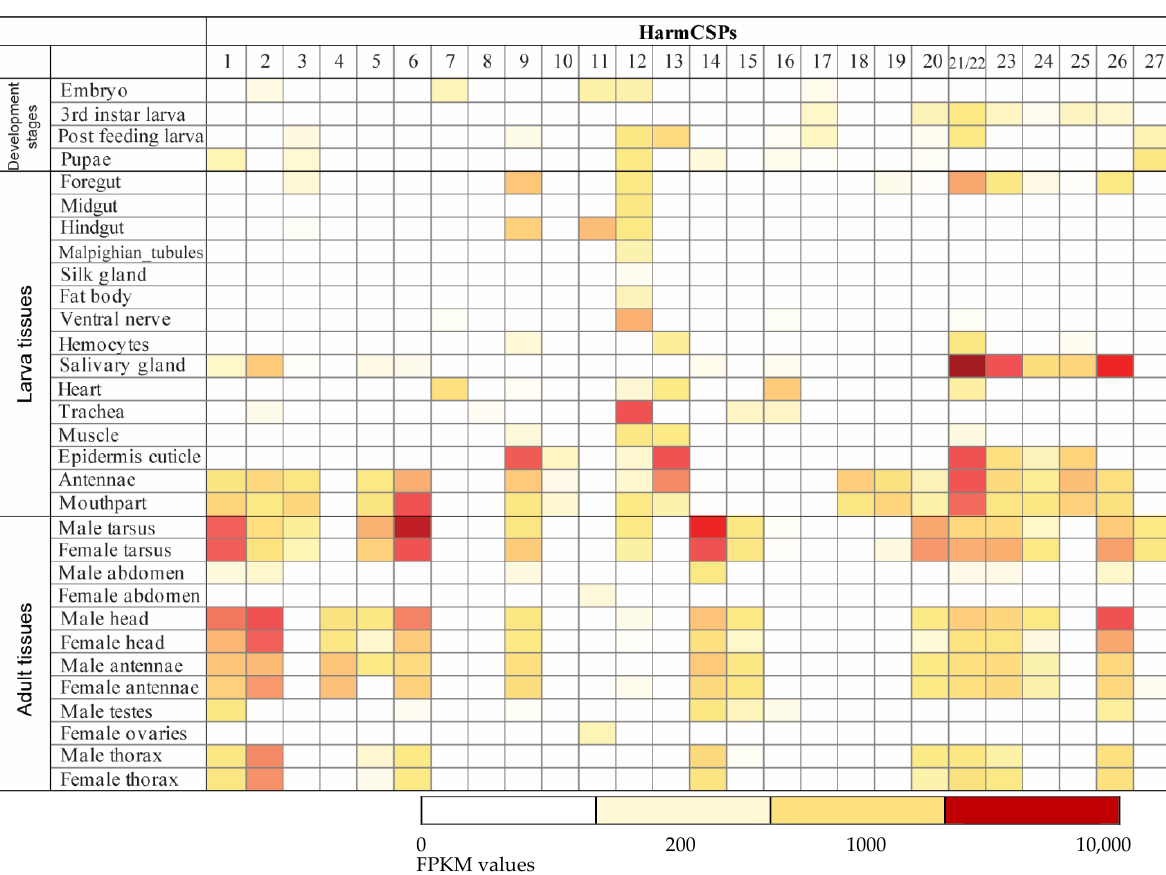
Figure 3. Expression profiles of H. armigera CSP genes. In silico expression of annotated HarmCSPs in studied tissues including: mouthparts, antennae, fat body, epidermis, malpighian tubules, foreguts, midguts, hindguts, hemocytes, trachea, hearts, silk glands, ventral nerve, salivary glands, and muscle of the 5th instar larvae; female heads, male heads, female antennae, male antennae, female thorax, male thorax, female tarsi, male tarsi, female testes, male ovaries, female abdomens, and male abdomens from day 0 to day 5 H. armigera adults; pupae, post-feeding stage larvae (whole body), 3rd instar larvae (whole body), and embryo. The color in the box indicates the level of FPKM value: Dark red, FPKM ≥ 10,000 ; yellow, FPKM = 200; and white, FPKM < 30.